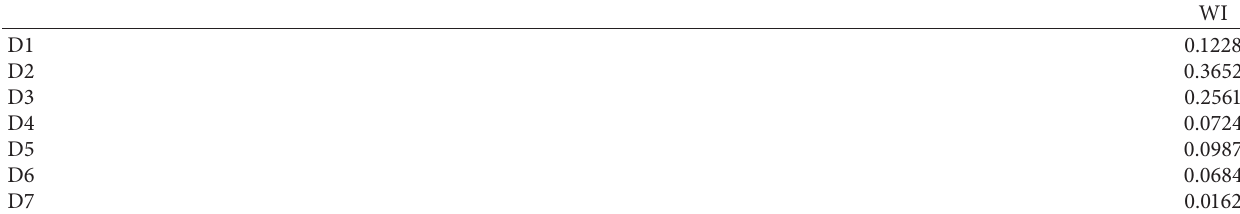
Table 12: Weights of criteria.